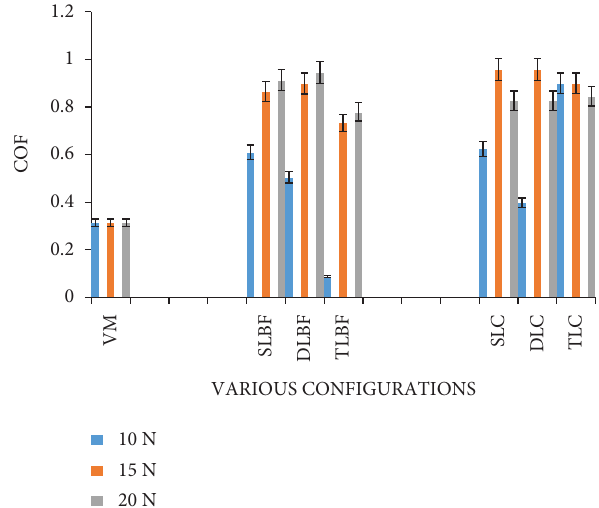
Figure 16: Comparative study of the coefcient of friction (with standard deviation) with diferent layers of silk fbre and silk cloth and the virgin